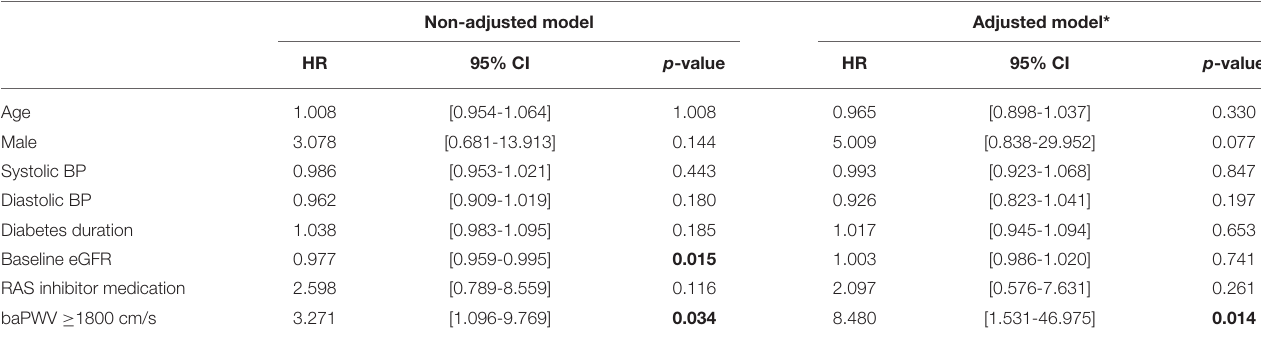
TABLE 4 | Risk of peripheral arterial stiffness (baPWV ≥ 1800 cm/s) on the progression of renal